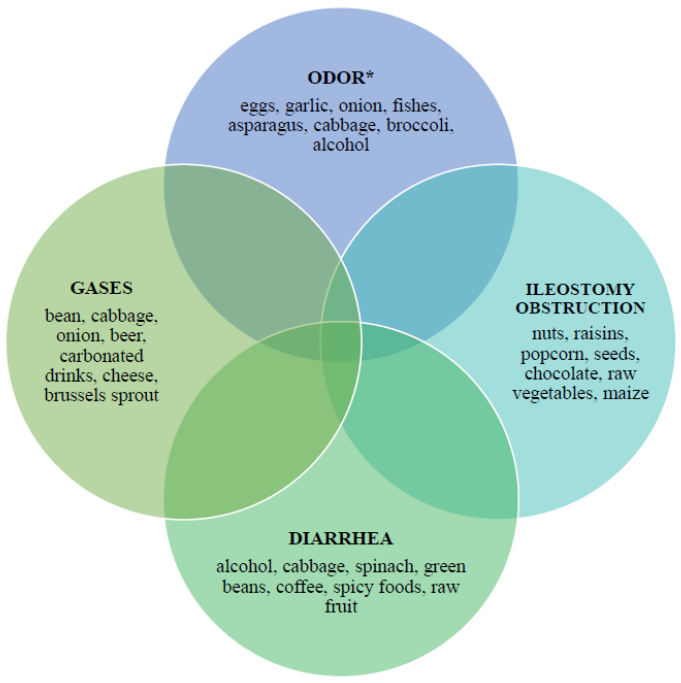
Figure 3. Foods that can cause selected types of digestive tract complications in patients with a stoma [41]. * Products that can reduce unpleasant odor: cranberry juice, parsley, buttermilk and yoghurt.